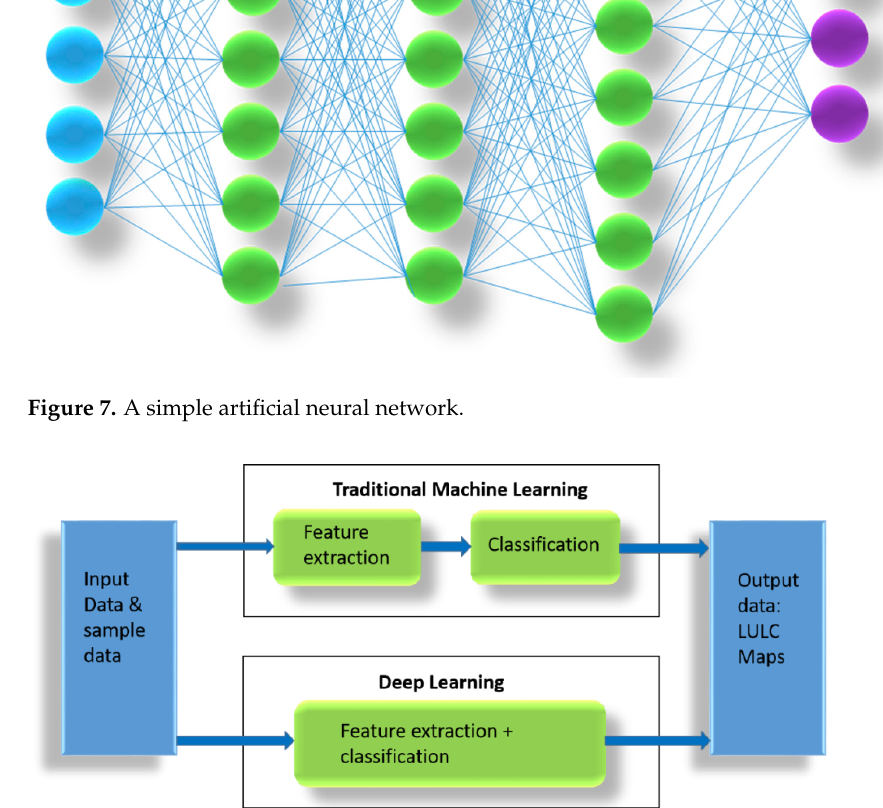
Figure 8. Differences between traditional machine learning and deep learning.